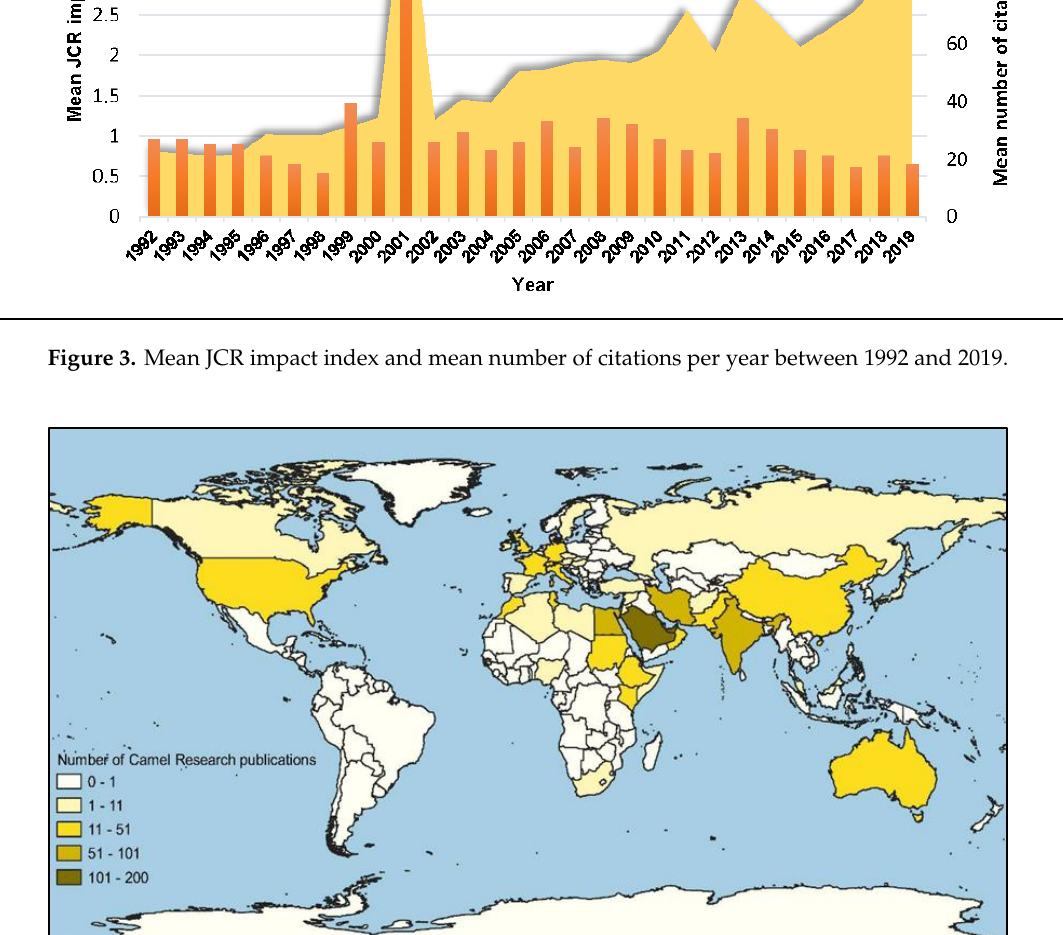
Figure 5. Number of scientific publications per country and research item within camel science.